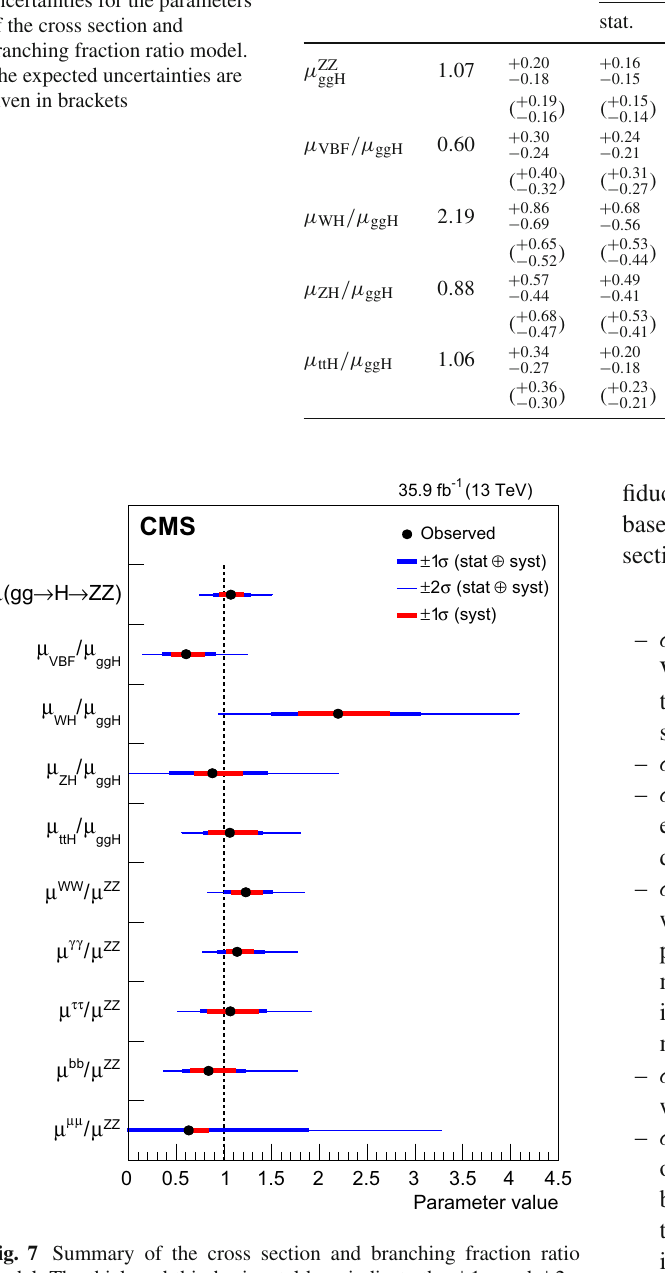
plate cross sections proposed in Ref. [53]. The results given here are for the stage 0 fiducial regions defined by the rapid- ity of the Higgs boson | y H | < 2 . 5. All input analyses have a negligible acceptance for | y H | > 2 . 5. Defining the fidu- cial region in this way reduces the theoretical uncertainty that would otherwise apply while extrapolating to the fully inclusive phase space. Subsequent stages involve splitting